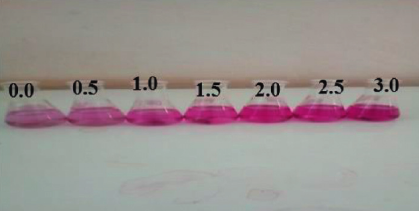
Figure 2: Color intensifications upon fluoride level increments on the addition of different amounts of fluoride from 0.5 to 3.0mg/L to 5.0 × 10 –5 M metal-EBT 1:1 complex.